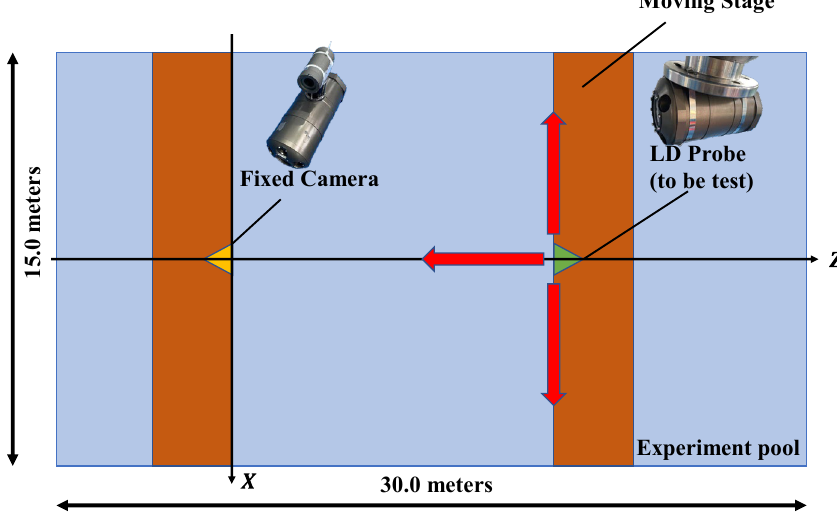
Figure 4. The condition of the experiment (top view).